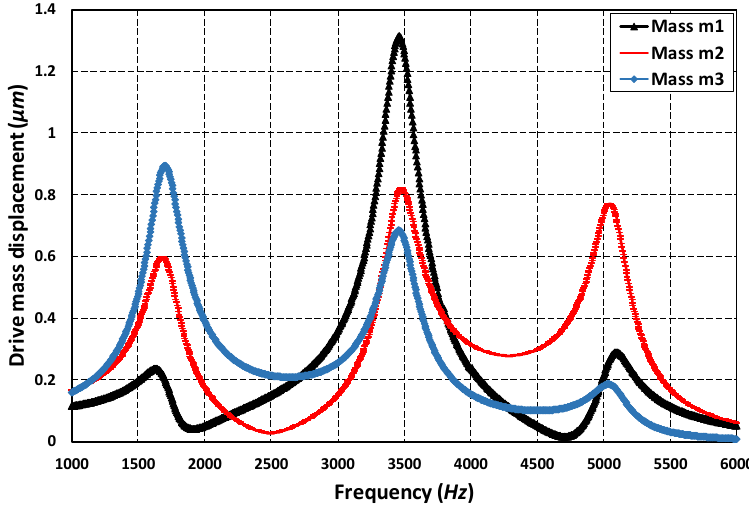
Figure 9. The frequency response of the 3-DoF drive mode oscillator.